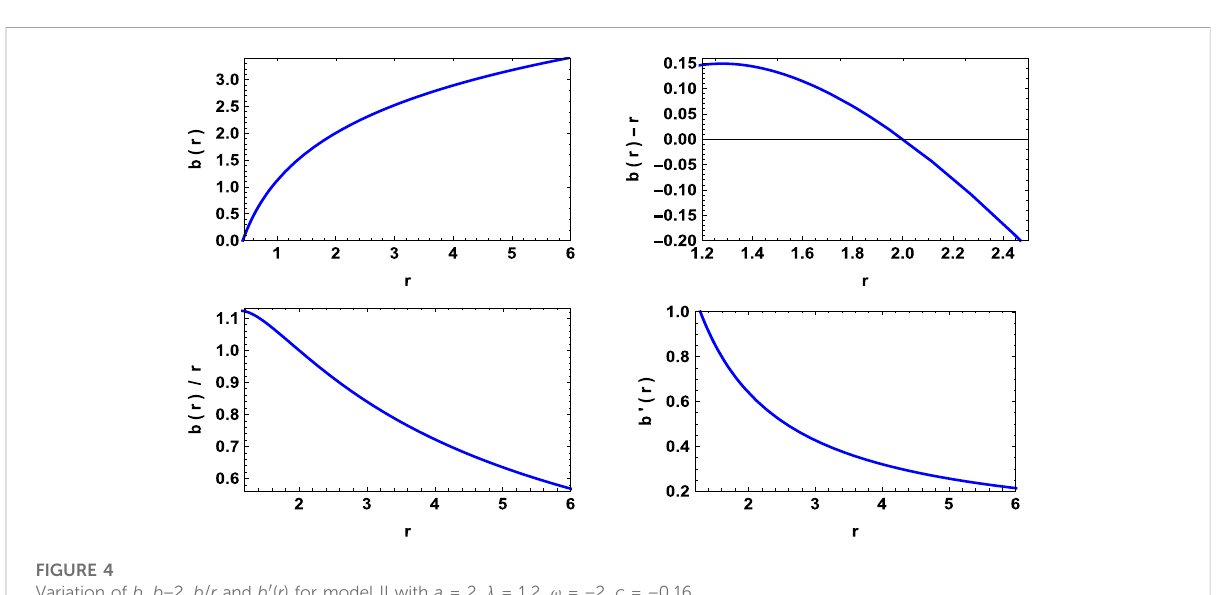
FIGURE 4 Variation of b , b − 2, b / r and b ′ ( r ) for model II with a = 2, λ = 1.2, ω = − 2, c = −